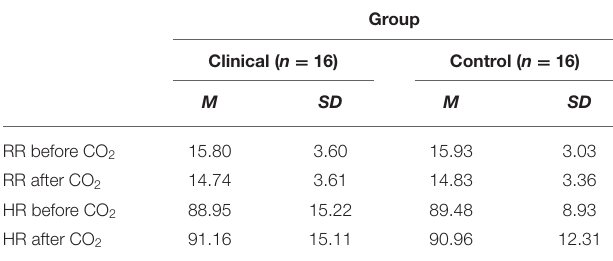
TABLE 6 | Descriptive statistics for heart rate and respiration rate before and after